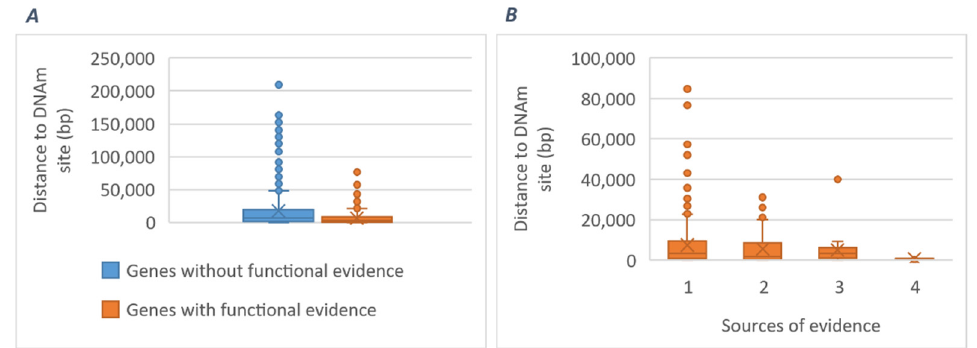
Figure 6. Comparison of the physical distance of 219 genes with and 613 genes without any functional evidence ( A ), as well as of 219 genes with different sources of evidence ( B ) to their nearest DNA methylation (DNAm) sites. DNAm signals are generated by the MSMR analysis (SMR analysis of GWAS vs. mQTL) and are mapped to their nearest genes based on Ensemble GRCh37 release 98.